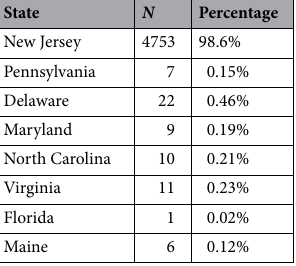
Table 1. Number of cases presented to the Marine Mammal Stranding Center according to state of origin between 1976 and 2016.